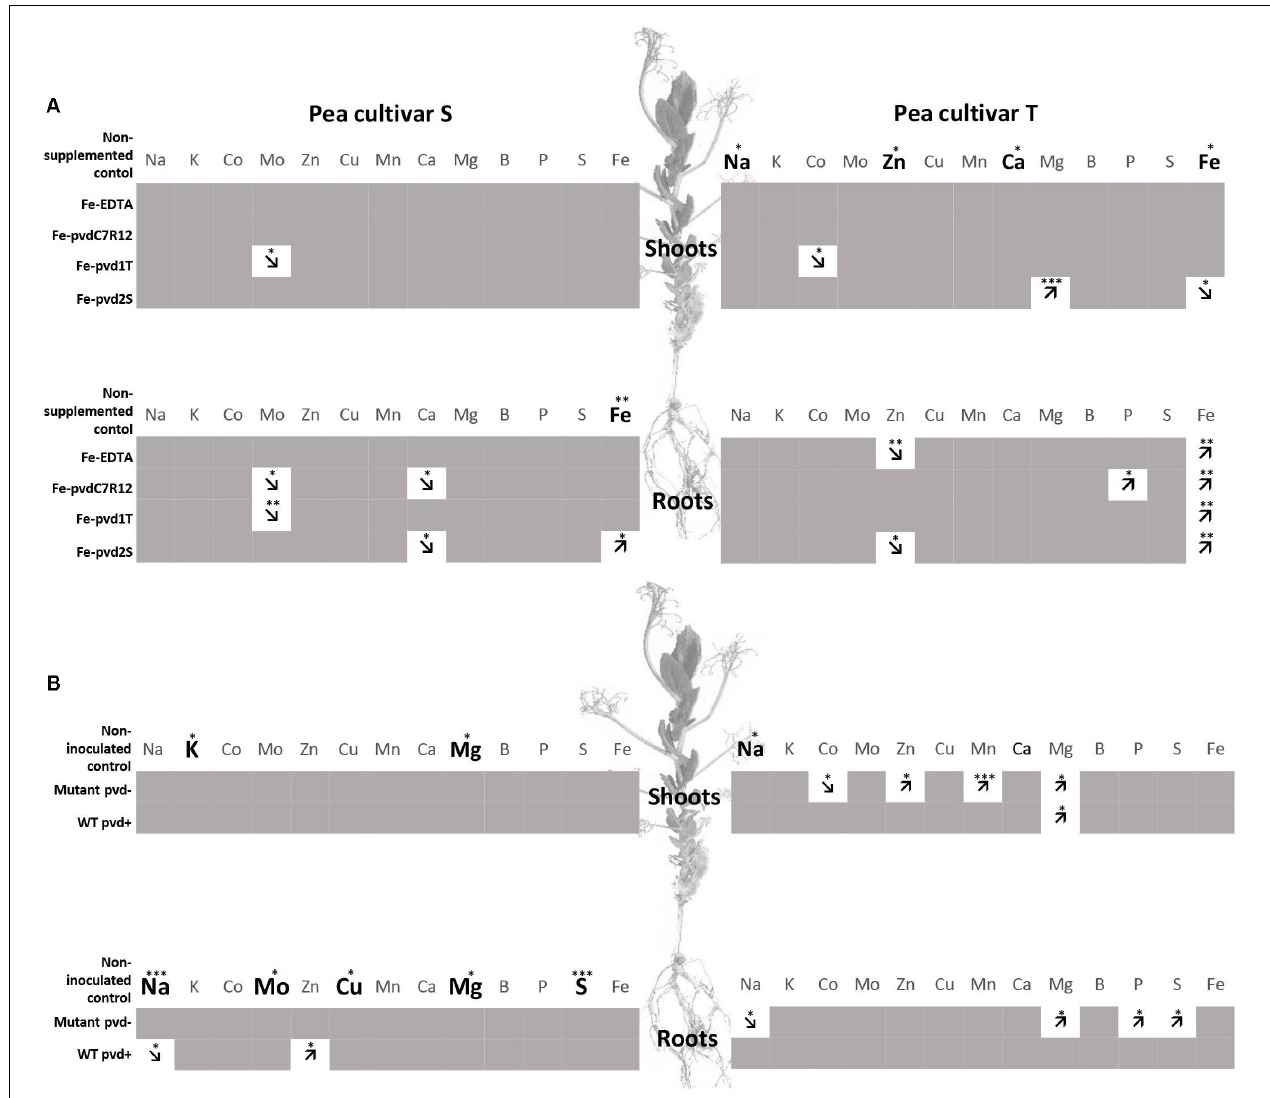
FIGURE 3 | Comparison of element concentrations in two pea cultivars, tolerant (T) and susceptible (S) to iron chlorosis, grown in vitro ( n = 3), (A) supplemented or not with Fe-EDTA, Fe-pvdC7R12, Fe-pvd1T or Fe-pvd2S, or (B) supplemented with Fe-EDTA (1 µ M) and inoculated or not with the wild type strain of P. fluorescens C7R12 (WT pvd + ) and its PL1 pvd − mutant (Mutant pvd − ). Bold characters highlight those elements for which the concentrations were significantly higher in one cultivar, as compared to the other, within a same plant compartment, in the non-supplemented plants for panel (A) , and in the non-inoculated plants for panel (B) . Arrows indicate increase or decrease of element concentration in comparison to the corresponding control within a same plant compartment and in a same cultivar after iron supplementation for panel (A) , or bacterial inoculation for panel (B) . ANOVA p -values. * p < 0.05; ** p < 0.01; *** p <